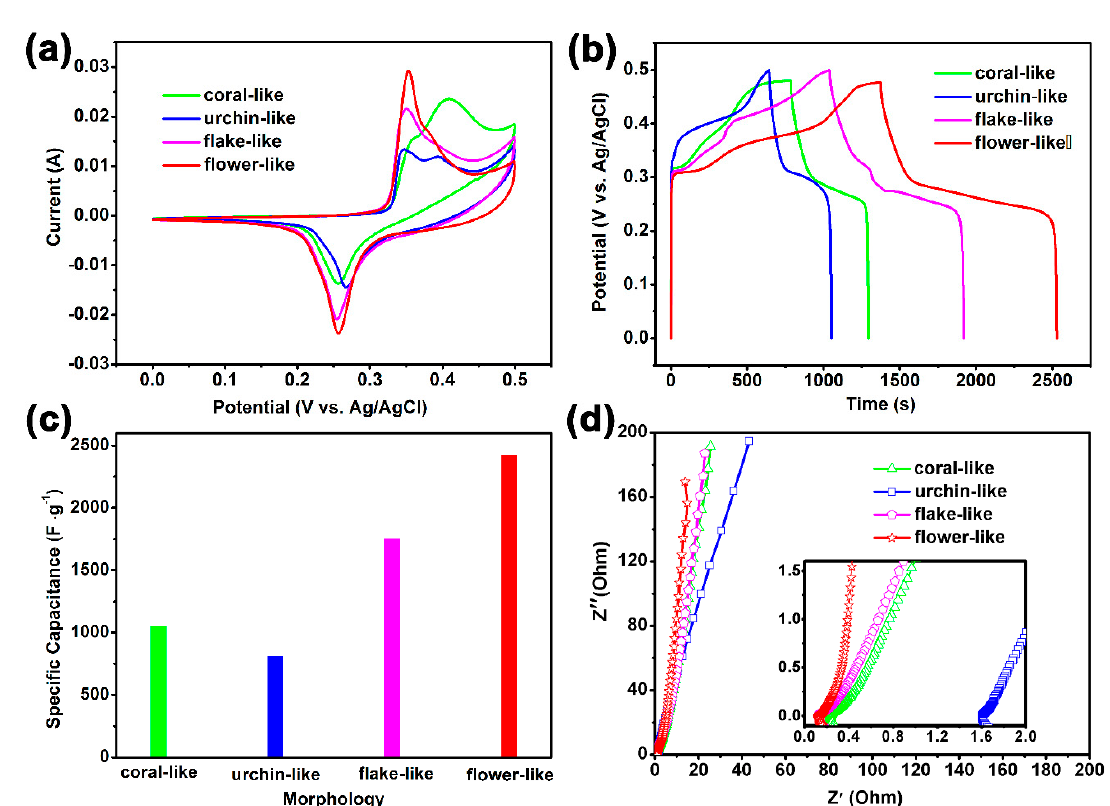
Figure 4. Electrochemical performances of the coral-like, urchin-like, flake-like, and flower-like β -NiS: ( a ) CV curves at a scan rate of 2 mV · s − 1 , ( b ) GCD curves at a current density of 1 A · g − 1 , ( c ) the values of the specific capacitance at a current density of 1 A · g − 1 , and ( d ) Nyquist plots and the magnified higher frequency